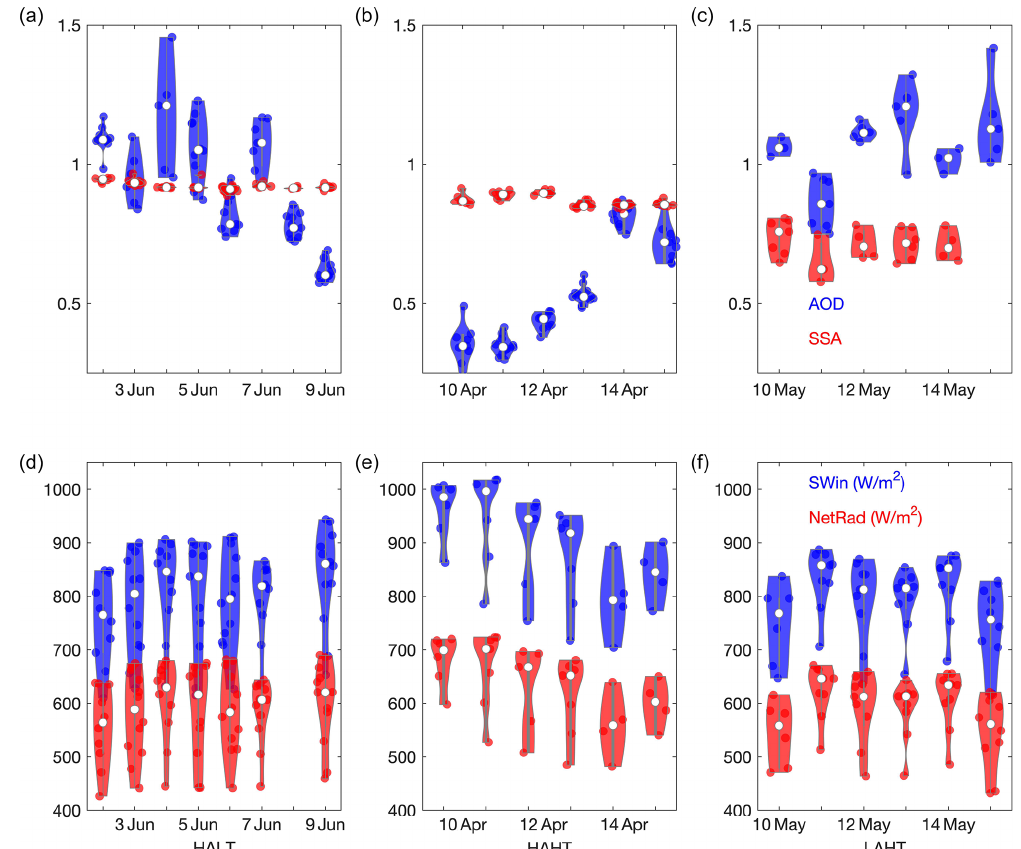
Figure 2. Distribution plots showing the variations in aerosol and radiation during the cases. Panels (a) – (c) illustrate the time series of the midday (11:00–14:00LT) variation in AOD and SSA values during HALT, HAHT, and LAHT, respectively. The horizontal line within the box represents median of the distribution. The hollow circle within the violin distribution represents median of the distribution. Panels (d) – (f) are the same as panels (a) – (c) but show measurements of incoming shortwave radiation and net radiation at surface. Note that 5 Jun HALT means 5 June of the HALT case and so